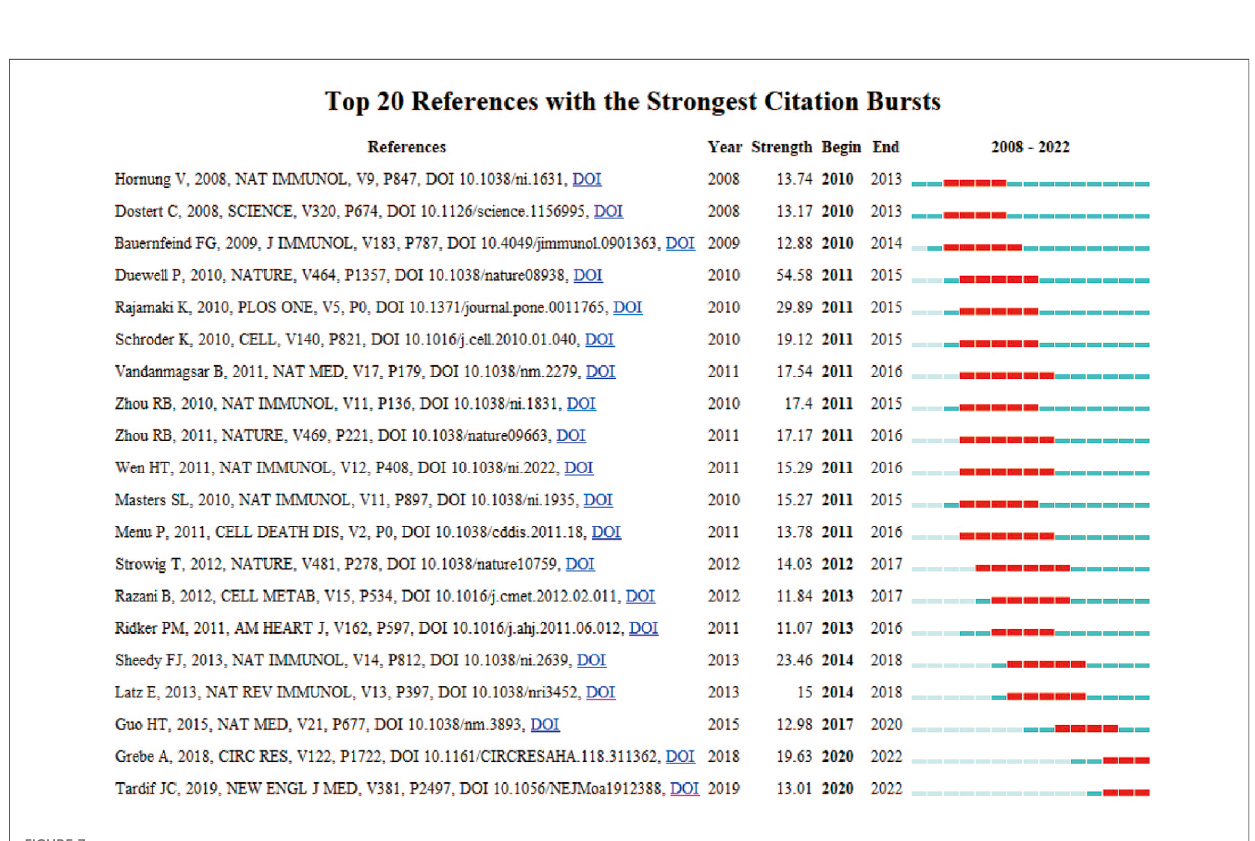
FIGURE 7 Top 20 references with the strongest citation bursts by CiteSpace.